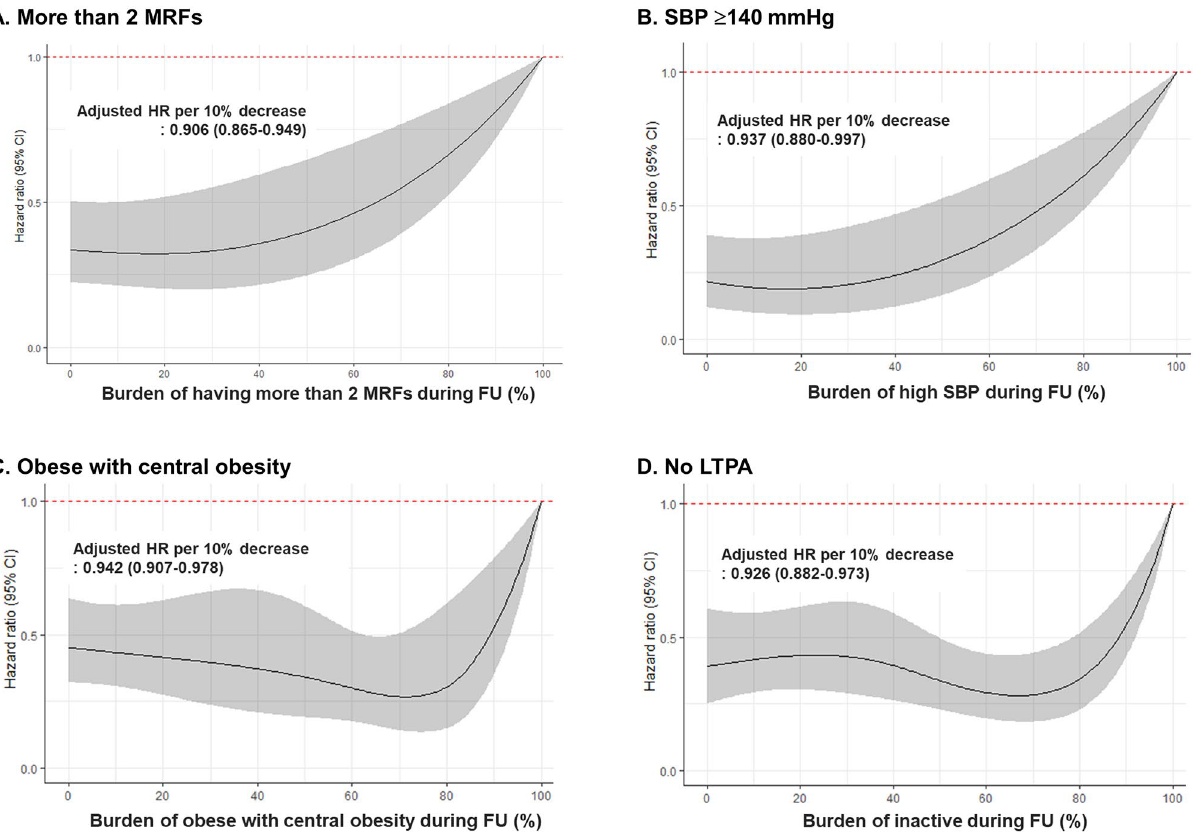
Figure 2. Associations of burden of having more than 2 MRFs ( A ), high SBP ( B ), obese with central obesity ( C ) and inactive ( D ) with risk of AF during follow-up. The solid black line and shaded gray areas represent hazard ratio and 95% confidence bands. Restricted cubic splines with 5 knots located at the 5th, 25th, 50th, 75th and 95th percentiles for hazard ratios were calculated with a burden of 100% as a reference. MRFs = modifiable risk factors; SBP = systolic blood pressure; LTPA = leisure time physical activity; HR = hazard ratio; CI = confidence interval; AF = atrial